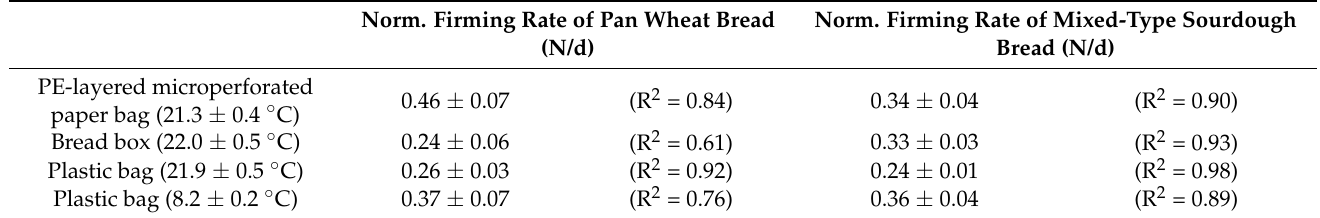
Table 4. Firming rates for different storage conditions and bread types after normalization. The results are shown in the table in terms of the firming rate, defined as the slope of the linear model (x ± STD, n =